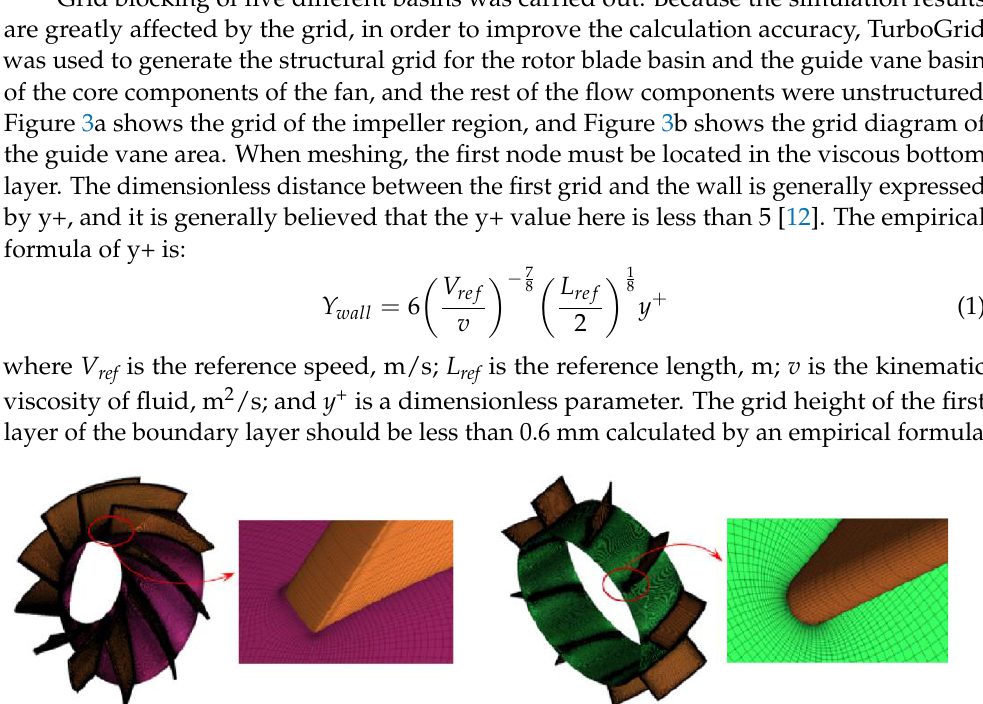
Figure 2. Fan basin diagram.